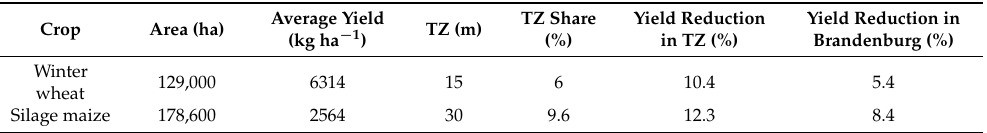
Table 3. Calculation of the yield reduction due to shading of the forest edges, for the winter wheat (grain yield) and the silage maize (whole plant), in Brandenburg. TZ shares were taken from Table 2, TZ length and yield reduction in TZ are the calculated values in this article. Yield reduction in Brandenburg was calculated, in comparison to no-shading in TZ.